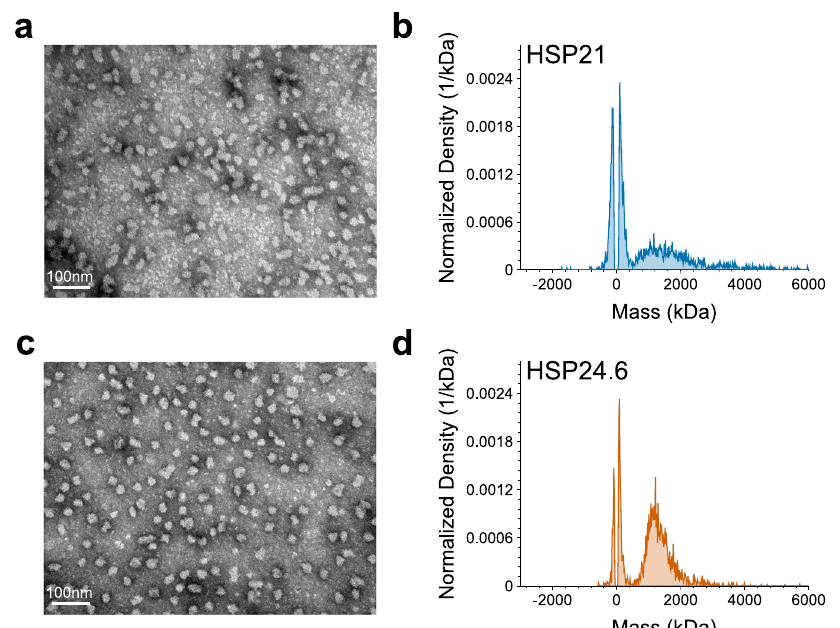
Fig. 3 HSP21 and HSP24.6 can form large oligomeric complexes. a Negative staining TEM of HSP21 reveals large assemblies of variable size and shape. b Mass photometry analysis indicates two populations of HSP21, a peak of smaller mass species — likely comprising limited oligomeric assembly — and a broad peak of larger mass species that likely includes a range of oligomeric states. c Negative staining TEM of HSP24.6 shows particles of more regular size and shape than HSP21. d Mass photometry analysis reveals HSP24.6 protein complexes of larger size that likely represent large oligomeric assemblies, in addition to a peak at lower mass representing smaller assemblies. Proteins were diluted in 1x PBS for mass photometry, and in molecular grade water for